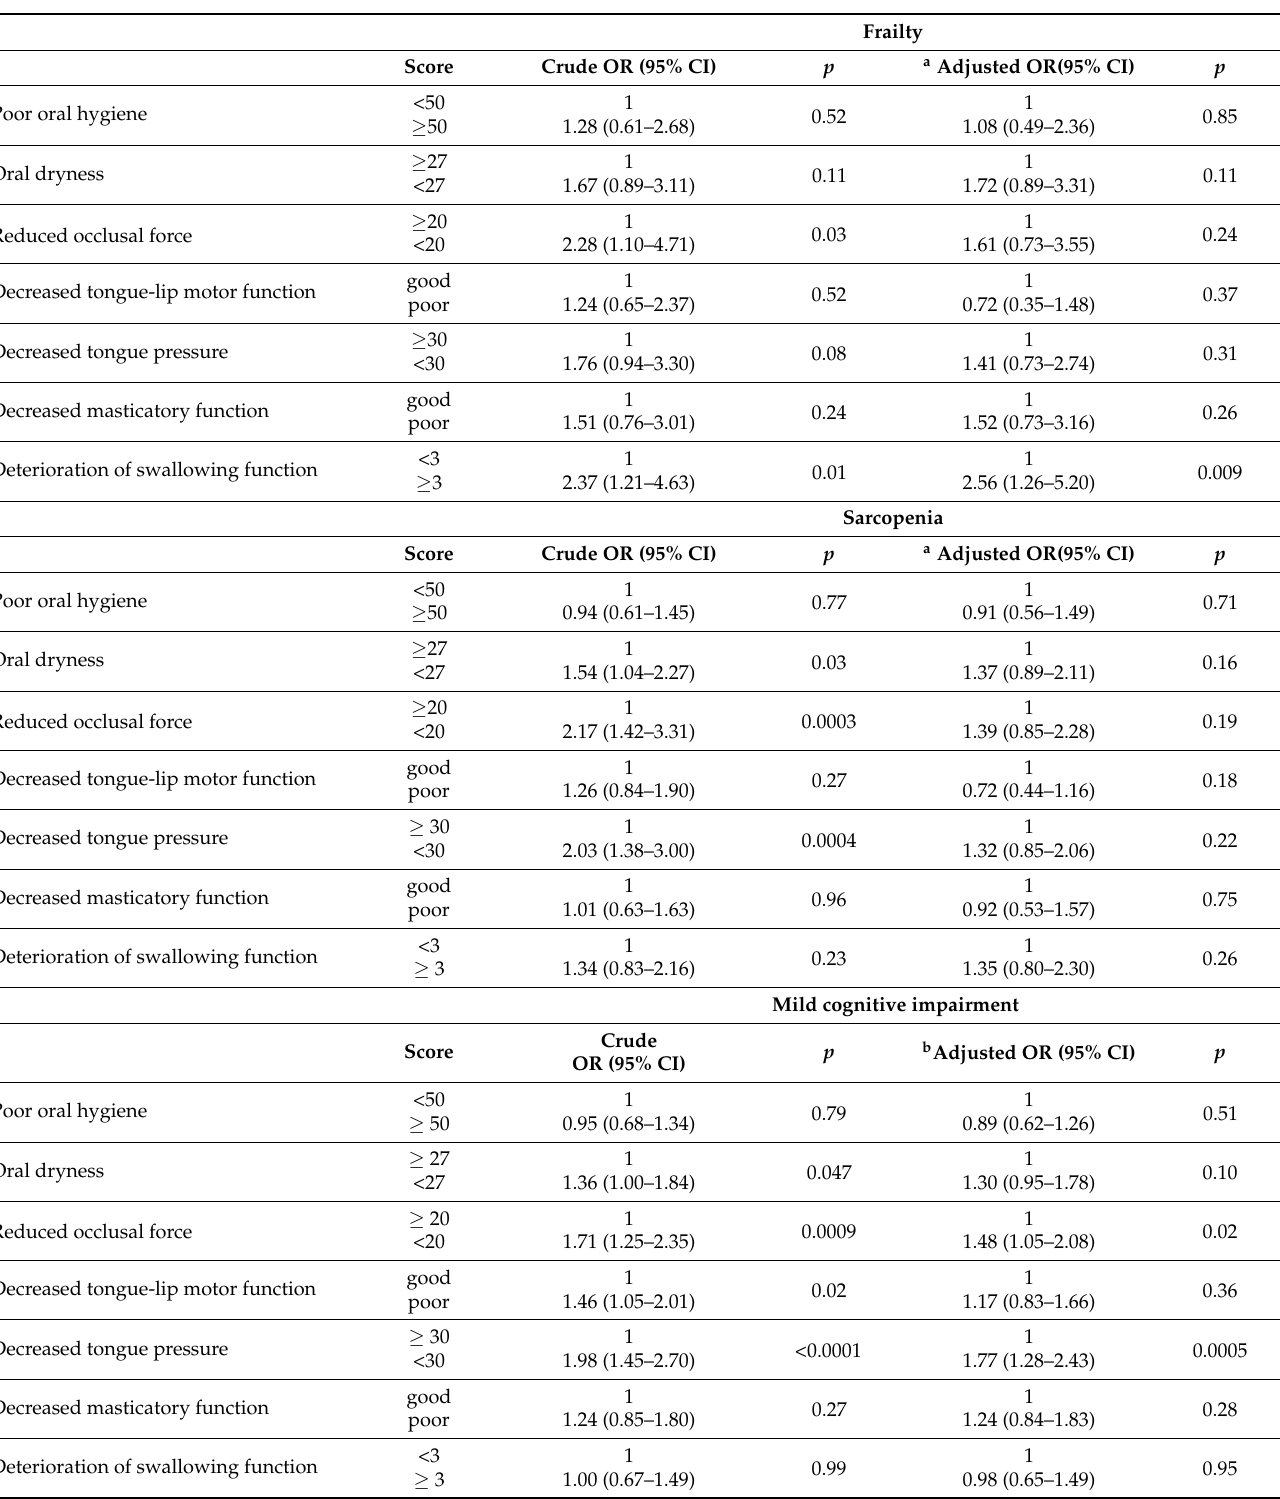
Table 3. Odds Ratios for Frailty, Sarcopenia, and Mild Cognitive Impairment According to Oral